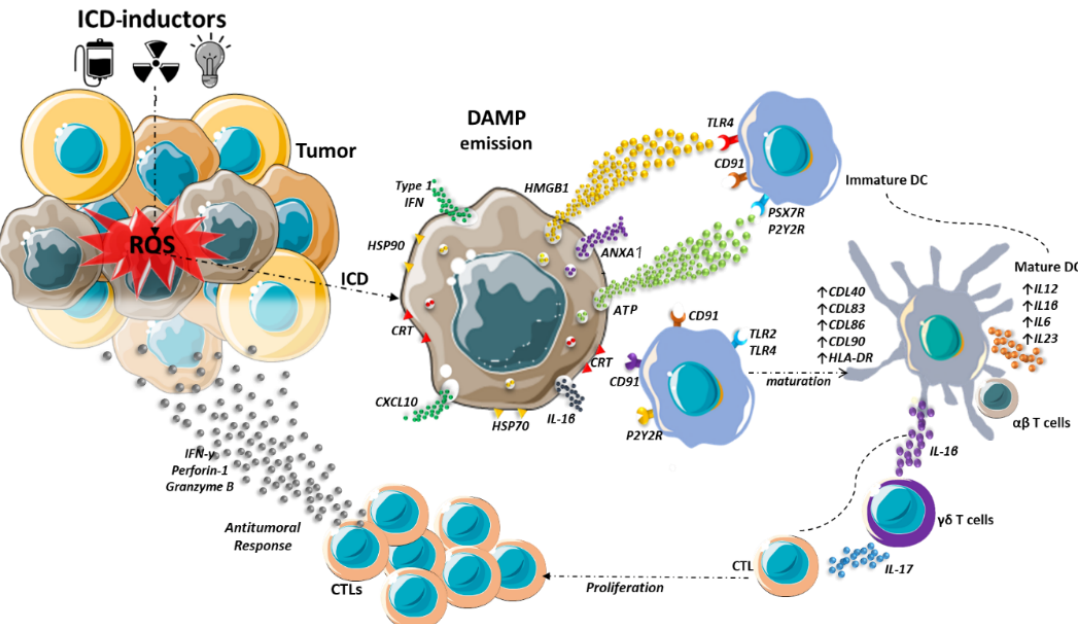
Figure 1. Engagement of adaptive immune response after immunogenic cell death in a tumor. Chemotherapy, radiotherapy, and photodynamic therapy can induce immunogenic cell death (ICD), which is a programmed cell death accompanied by the exposure of damage-associated molecular patterns (DAMPs). This can occur, for instance, as a consequence of oxidative stress in the endoplasmic reticulum. Some DAMPs, such as heat-shock protein (HSP)70, HSP90, and calreticulin are exposed on the plasma membrane, while others such as adenosine triphosphate (ATP), high mobility group box 1 protein (HMGB1), C-X-C motif chemokine ligand 10 (CXCL10) and annexin A1 (ANXA-1) are released to the extracellular medium. DAMPs then activate pattern recognition receptors of dendritic cells (DCs) and other antigen-presenting cells. This culminates in the maturation of the DCs and in the recruitment and activation of T cells. In this way, ICD can trigger or boost an adaptive antitumor immune response.